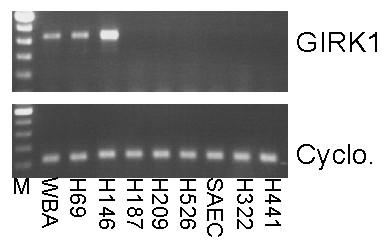
Expression of GIRK1 in some SCLC cell lines but not in normal SAE cells, nor in adenocarcinoma Clara cell phenotype cell lines. Top panel: GIRK1 is expressed in WBA, H69, and H146 SCLC cell lines but not in H187, H209 and H526 SCLC cell lines. GIRK1 is also not expressed in normal SAE cells, nor is it expressed in H322 or H441 adenocarcinoma Clara cell lines. Bottom panel: Cyclophilin, used as a positive reaction control was seen in all samples. For all gene expression experiments, negative control reactions were performed and found to be negative. The bands on the agarose gels were consistent with the expected sizes: GIRK1-441 bp; cyclophilin-216 bp; M-100 bp.